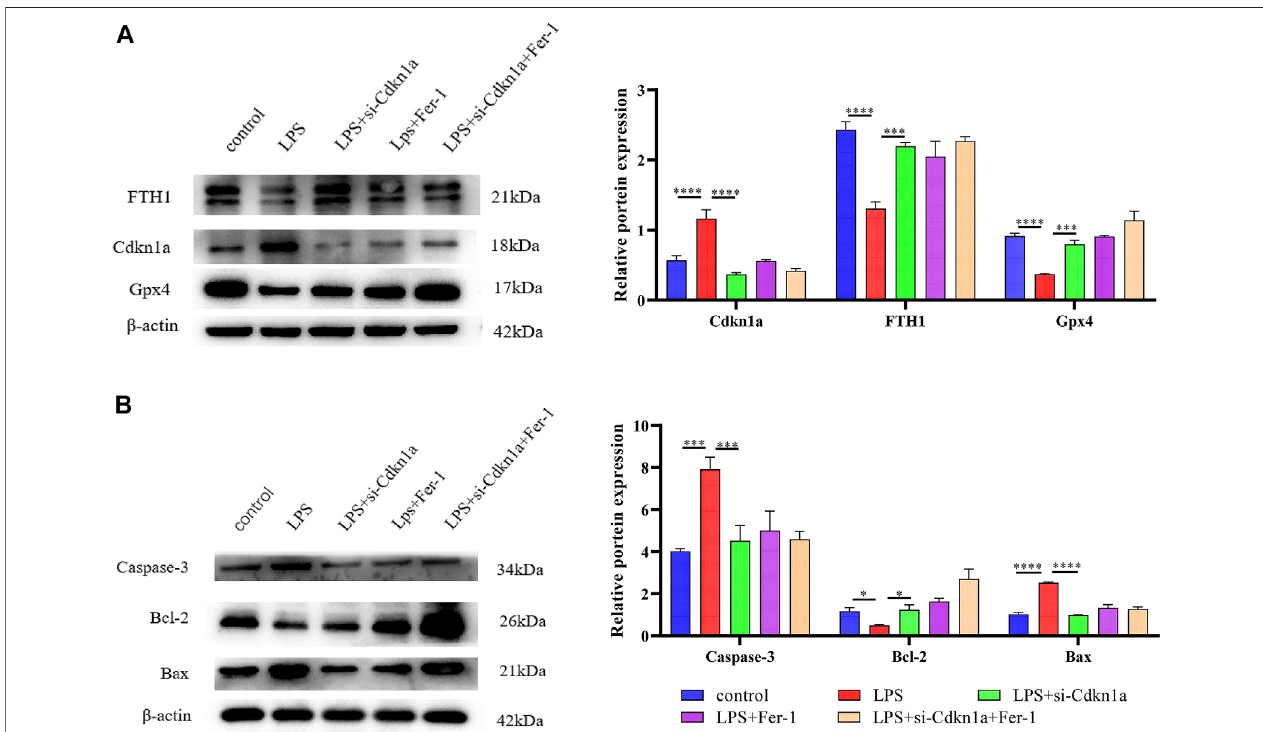
FIGURE8| TheresultsofWesternBlottingAnalysis.ThispartofthestudywasbasedontheuntreatedHL-1cellsandLPS-treatedHL-1cellsthatweretreatedwith Si- Cdkn1a or Fer-1 ( n = 3). (A) Western blotting was used for detecting GPX4, FTH1 and Cdkn1a expression in different HL-1 cells; (B) Western blotting was used for detecting Caspase-3, Bcl-2 and Bax expression in different HL-1 cells. *, p < 0.05; ***, p < 0.001; ****, p < 0.0001, Error bars represent the mean ± SD of triplicate experiments.